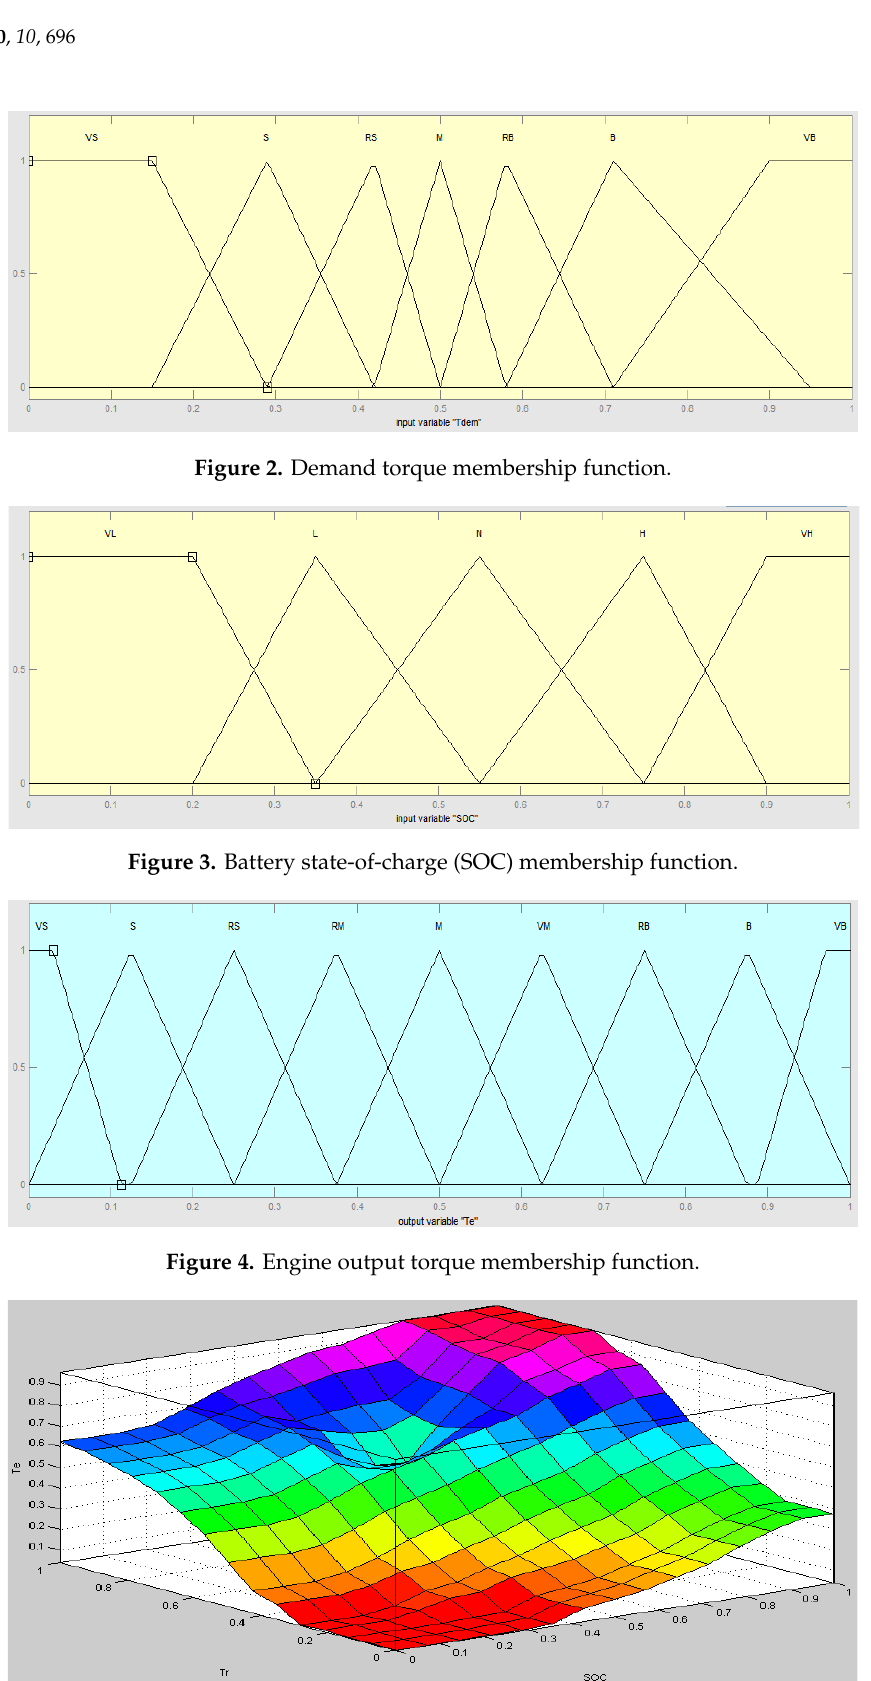
Figure 5. Fuzzy inference input–output map.